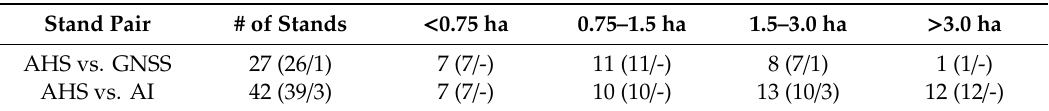
Table 5. The stand area categories and amounts of stands in comparison. The numbers in parentheses indicate amount of stands where the numerical GNSS estimate of harvester is more or less accurate, respectively. The abbreviation AHS denotes automated harvested stands and other abbreviations are as in Table 4. Stand Pair # of Stands < 0.75 ha AHS vs. AI